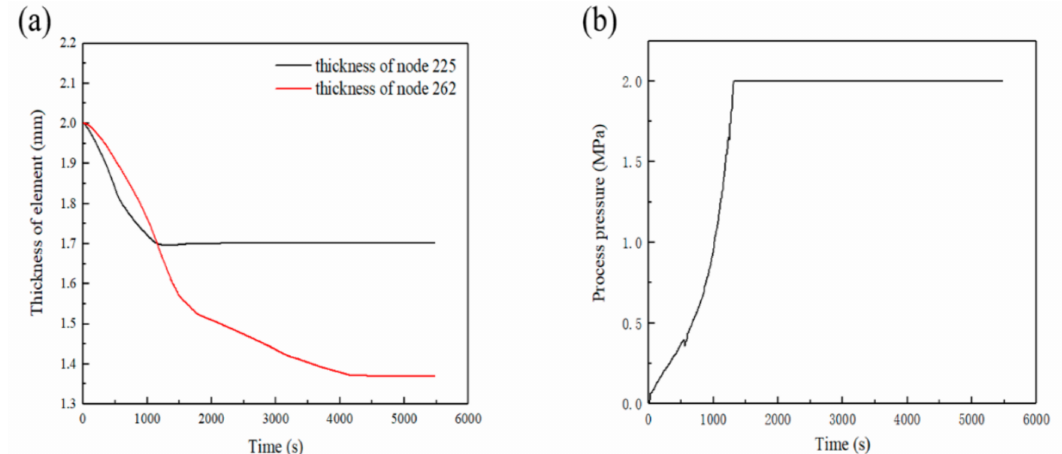
Figure 16. ( a ) The thickness-time curves of different nodes, ( b ) the process pressure-time curve predicted by FEA.